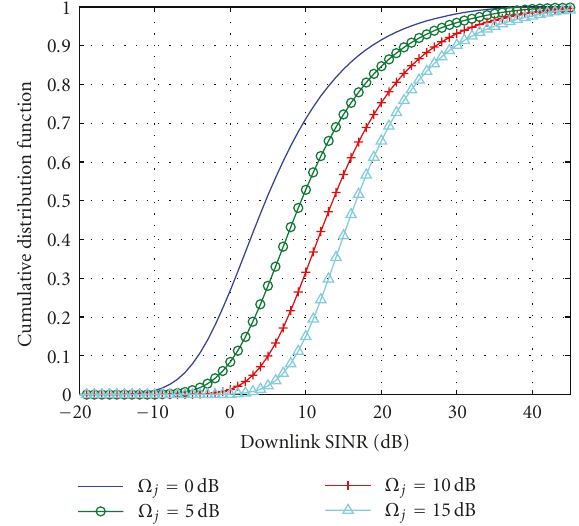
Figure 6: E ff ect of wall penetration loss on CDF of SINR (FW = σ = 3.5dB). method, σ X X j s